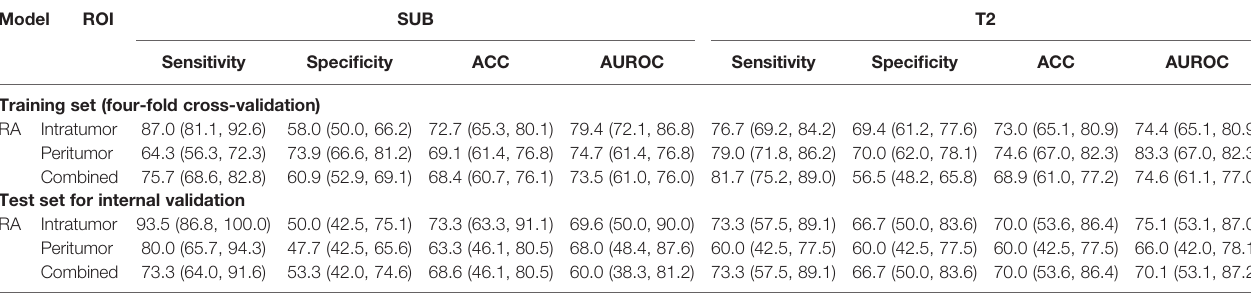
TABLE 3 | Comparison of the RA model performances between various ROIs for differentiating malignant from benign MR-detected additional lesions.